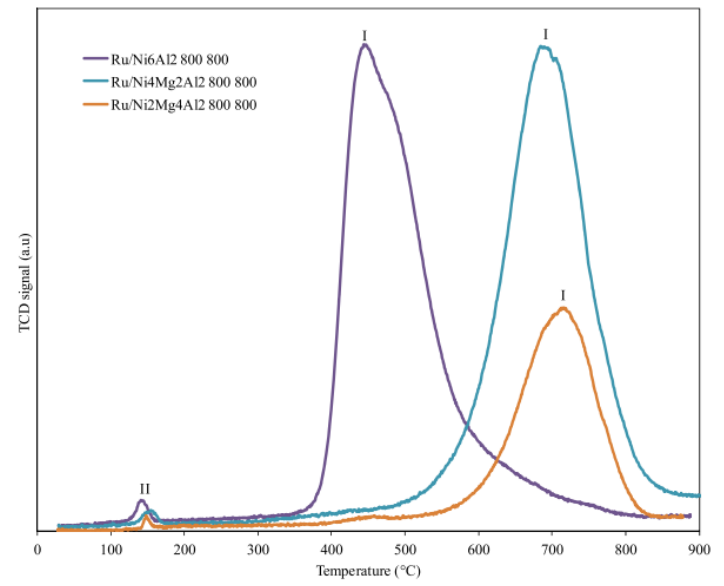
Figure 6. TPR profiles of Ru/Ni x Mg 6-x Al 2 samples (x = 2, 4 and 6). Reprinted with permission from [159], copyright 2015, Elsevier.